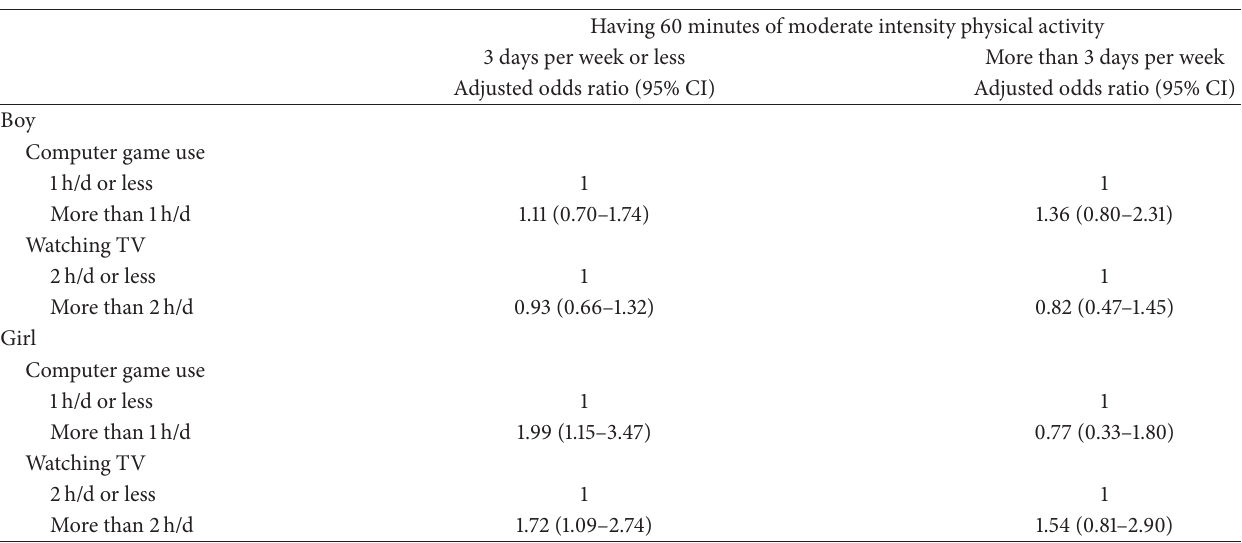
Table 3: Adjusted odds ratio for associations of computer game use and television viewing with overweight by physical activity levels and gender ∗